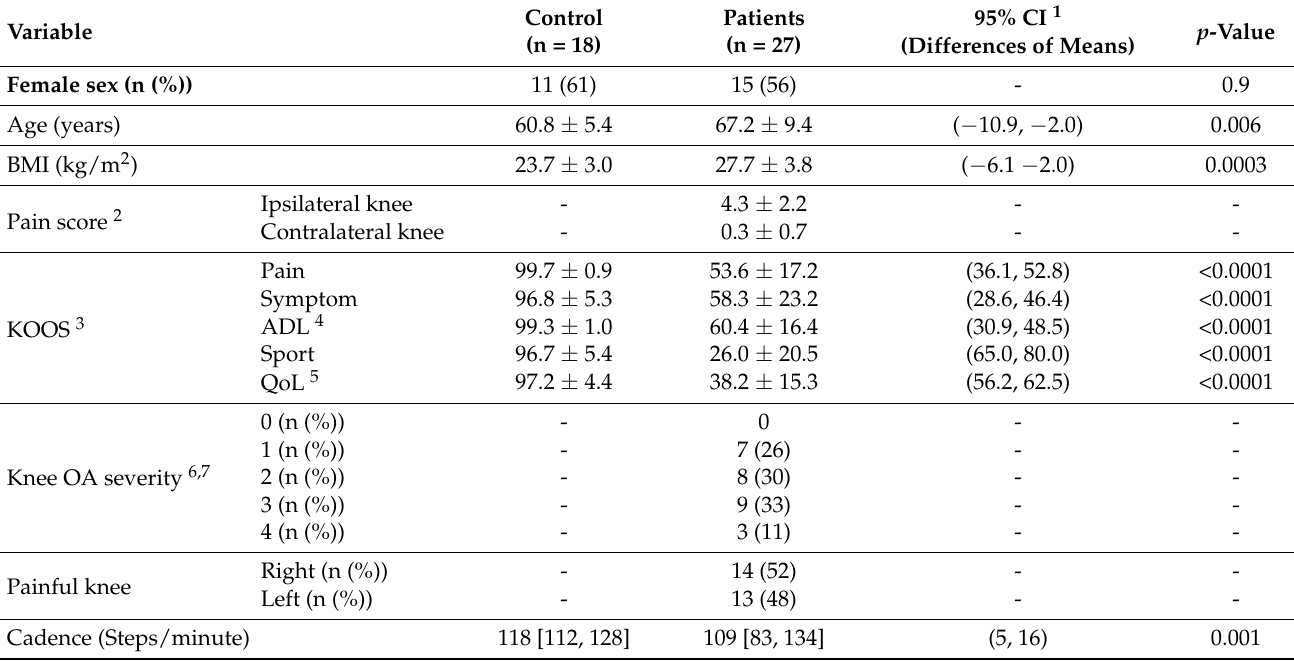
Table 2. Basic characteristics of the patients and controls.